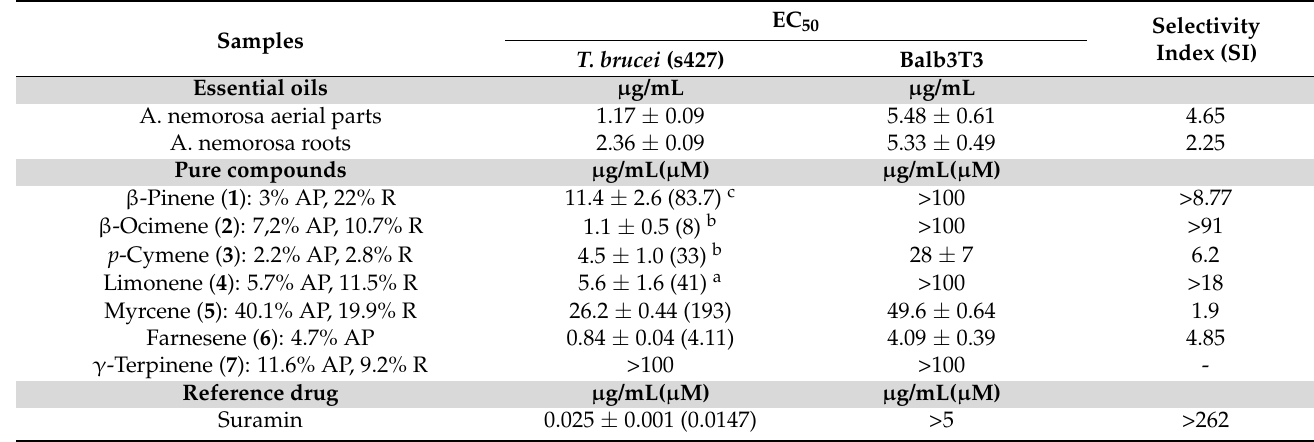
Table 2. Antitrypanosomal activity of A. nemorosa essential oils and pure compounds. For the pure compounds, their percentages in EOs from A. nemorosa aerial parts (AP) and roots (R) are also listed just after the names of the compounds.